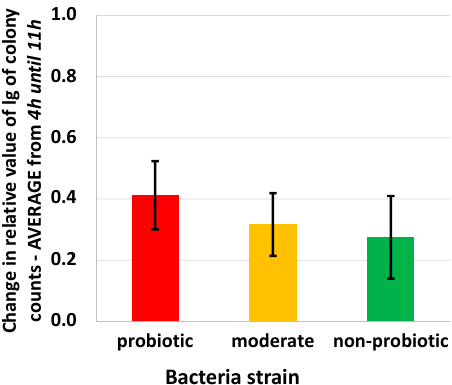
Figure 4. Change in the average relative colony counts from the initial 10 6 CFU / mL number for the probiotic, moderate, and non-probiotic groups from 4 h to 11 h of fermentation in milk ( n = 45).